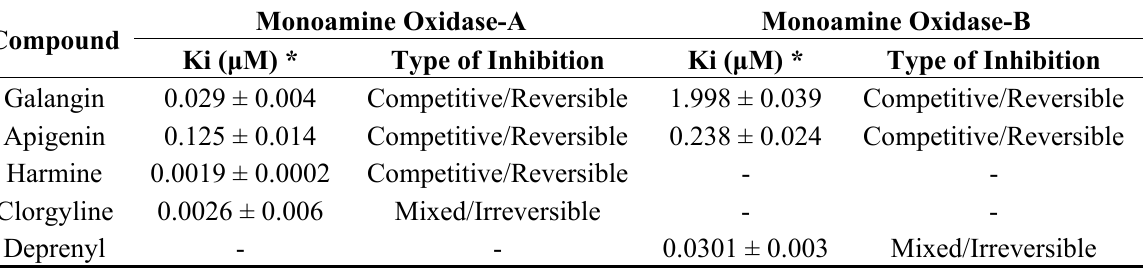
Table 2. Inhibition/binding affinity constants (Ki) values for inhibition of recombinant human MAO-A and B by galangin and